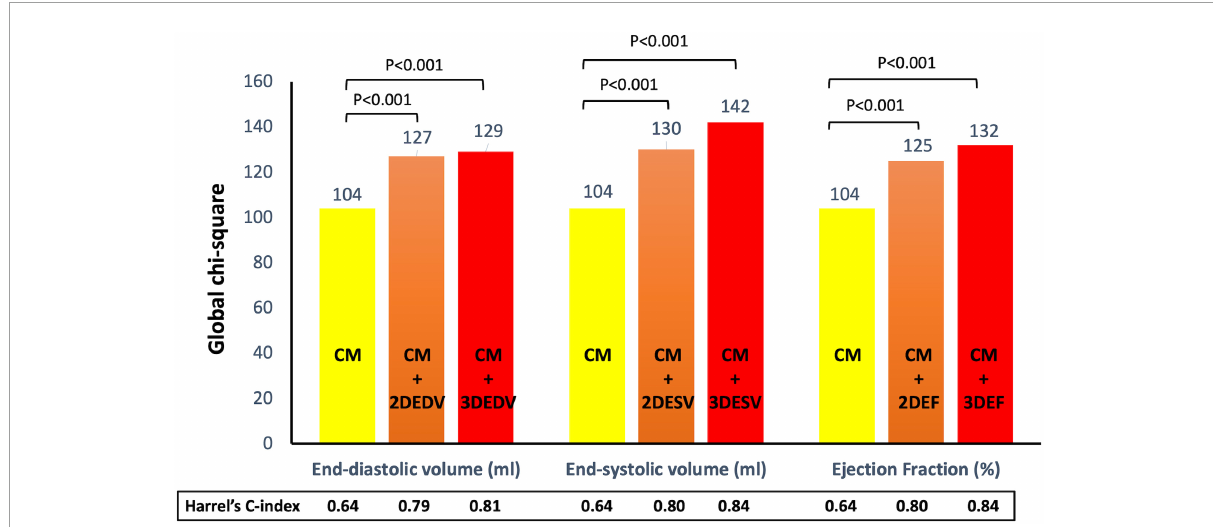
FIGURE6 Addition of left ventricular volumes and ejection fraction obtained from both two- and three-dimensional echocardiography significantly increased the association with the composite endpoint of all-cause death and cardiac hospitalization of the clinical model based on age, dyslipidemia, permanent atrial fibrillation, ischemic heart disease, and serum levels of creatinine and hemoglobin. Both three-dimensional end-systolic volume and ejection fraction had stronger association with outcome than the corresponding two-dimensional